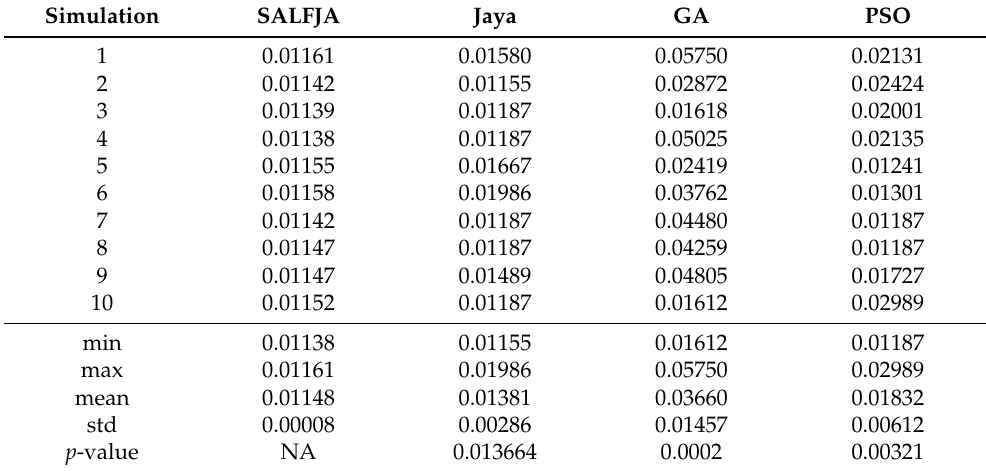
Table 6. PG and E 69 bus test system: Stochastic validation of proposed SALFJA algorithm for DG placement.